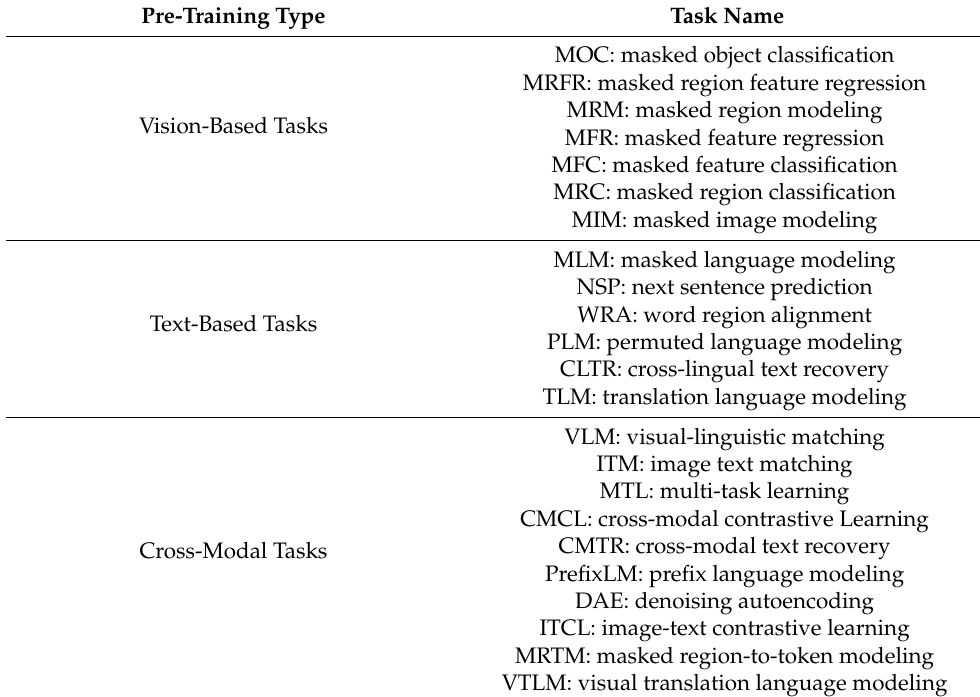
Table 2. Glossary of pre-training